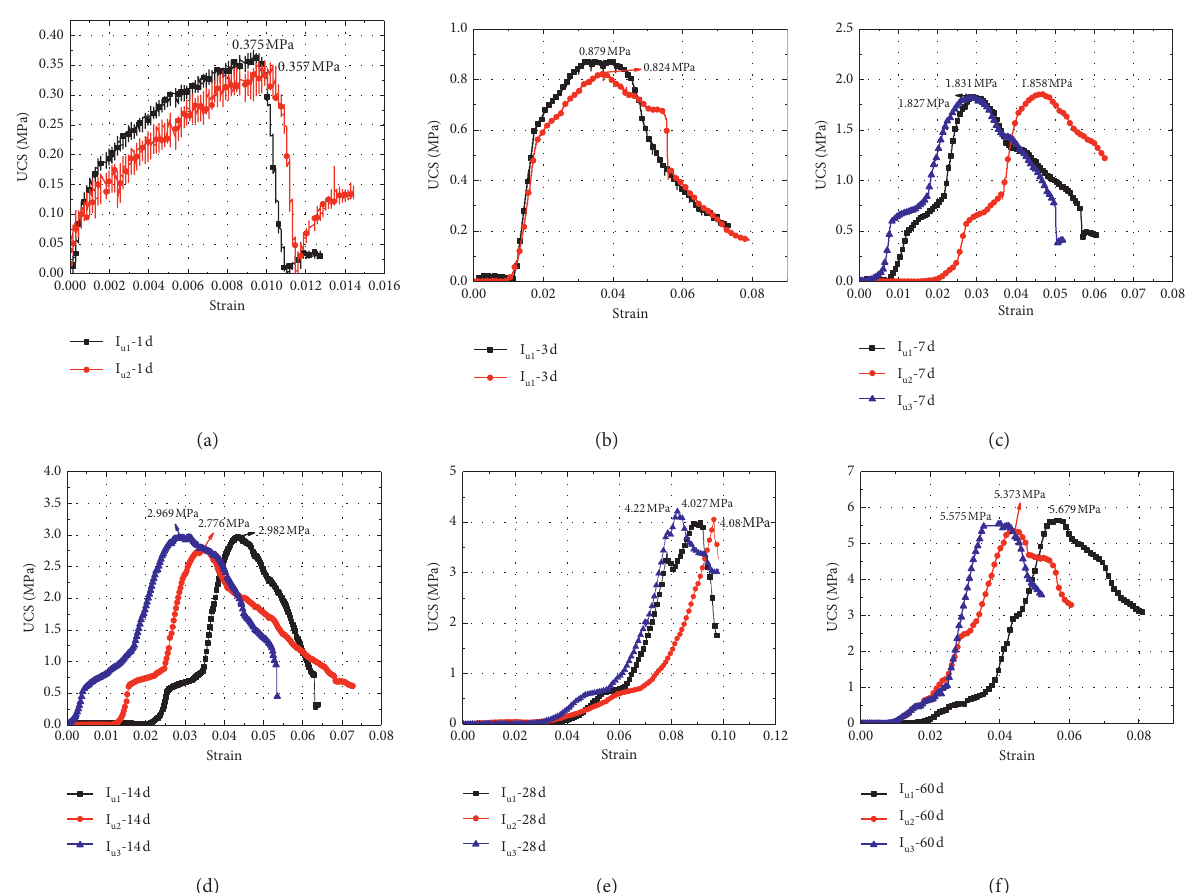
Figure 9: Mechanical strength of SCPB with different curing ages (blank control group I). (a) I u-1d. (b) Iu-3d. (c) Iu-7d. (d) Iu-14d. (e) Iu- 28d. (f) Iu-60d.